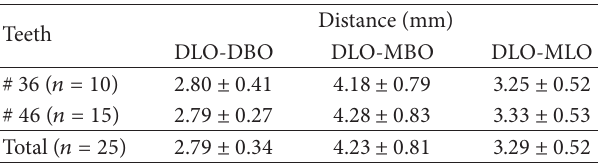
Table 2: Distances from DL orifice to other 3 orifices in 25 permanent three-rooted right and left mandibular first molars. Distance (mm) Teeth DLO-DBO DLO-MBO DLO-MLO # 36 ( 𝑛 = 10 ) 2.80 ± 0.41 4.18 ± 0.79 3.25 ± 0.52 # 46 ( 𝑛 = 15 ) 2.79 ± 0.27 4.28 ± 0.83 3.33 ± 0.53 Total ( 𝑛 = 25 ) 2.79 ± 0.34 4.23 ± 0.81 3.29 ±